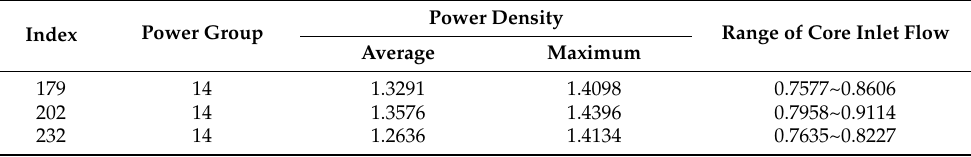
Table 3. Screened fuel assemblies expecting to be damaged in the whole core.